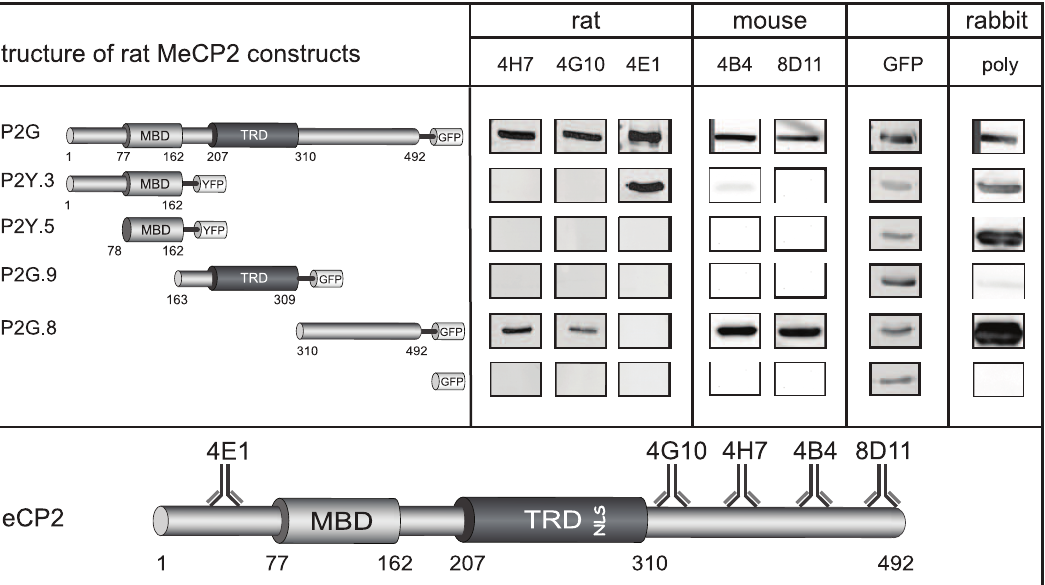
Figure 3. Epitope mapping. To determine the binding site of the new monoclonal antibodies within the MeCP2 protein, we probed extracts of mammalian cells expressing different MeCP2 constructs fused to GFP/YFP as indicated. To control for the level of the fusion proteins, the membranes were reprobed with anti GFP mouse monoclonal antibody. A summary of the epitope mapping results for the different antibodies is shown below. MeCP2 functional domains are as in Figure 1.